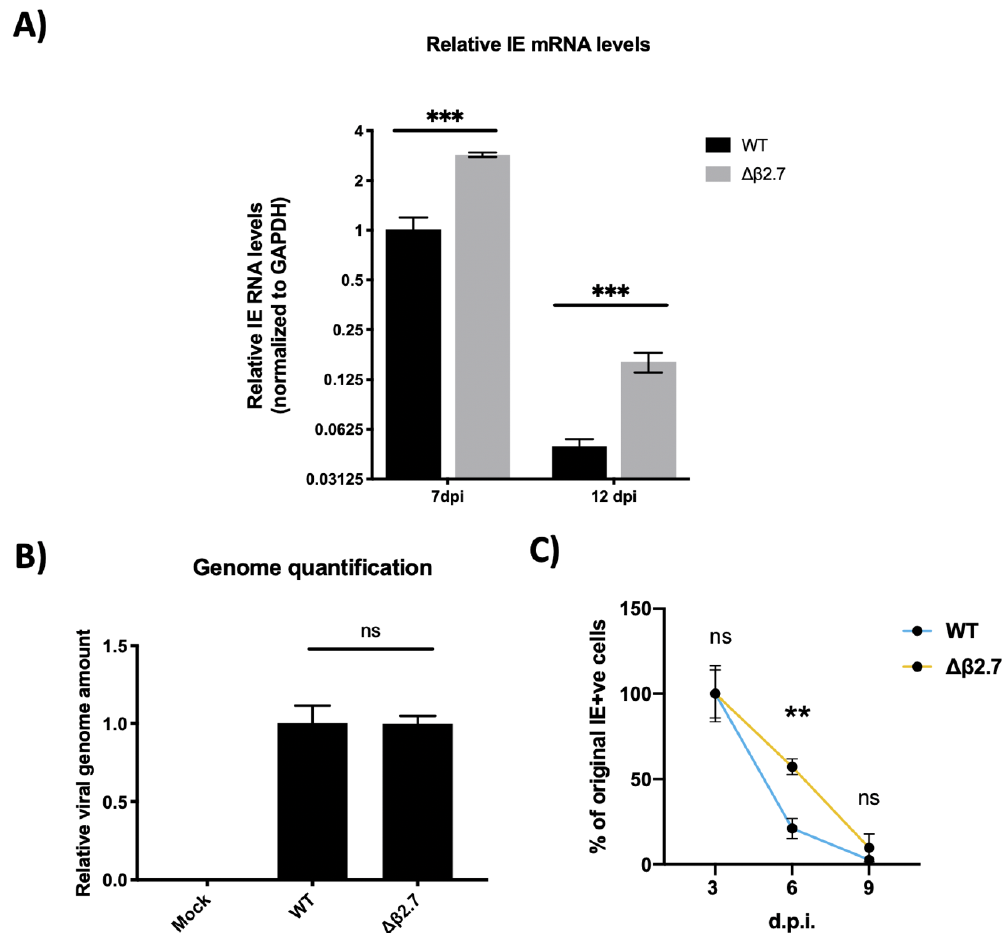
Figure 2. The Δβ2.7 deletion virus fails to silence major IE genes in primary monocytes. CD14+ monocytes were infected with WT SV40- GFP TB40E (WT) or Δβ2.7 SV40 - GFP TB40E (Δβ2.7) virus at an MOI of 3. ( A ) RNA was harvested and assayed for levels of IE72/86 and the housekeeping gene GAPDH by RTqPCR at 7 d.p.i and 12 d.p.i. Graphs show mean and standard deviation of three replicates. Significance was determined by two-tailed Student’s t -test. *** = p < 0.001. ( B ) DNA was harvested from infected monocytes at 1 d.p.i and assessed for levels of the promotor regions of UL44 and GAPDH by qP CR. A significant difference between WT and Δβ2.7 genome levels was determined with a two-tailed Student’s t -test. ns = (not significant). ( C ) Infected monocytes were fixed at 3, 6 and 9 d.p.i and stained for IE72/86. IE-positive monocytes from 3 replicates were enumerated. Graph shows the mean % and standard deviation of IE-positive cells at 6 and 9 d.p.i relative to 3 d.p.i. Significant difference was determined by a 2-way ANOVA with Sidak’s multiple comparison testing. ** = p < 0.01.